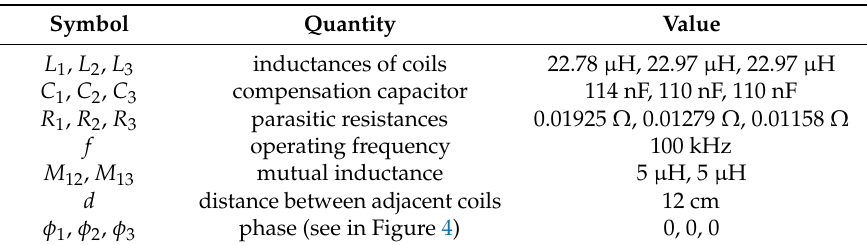
Table 1. Key parameters of proposed system.